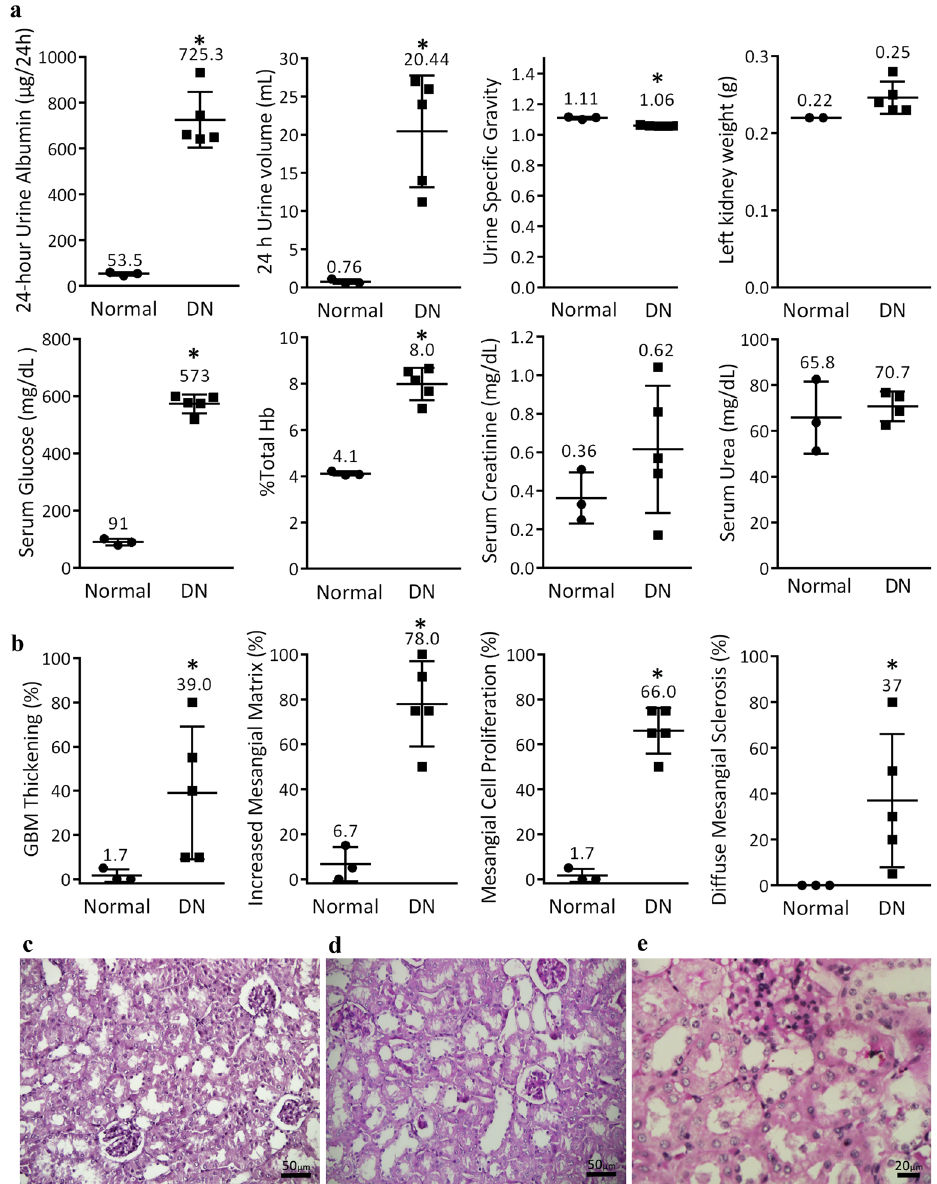
Figure 2. The mouse model of DN was validated with different parameters. A mouse model of DN was established using streptozotocin and validated after 3 months using functional ( a ) and histopathological ( b ) assessments. Representative fields of normal ( c ) and DN ( d , e ) kidneys are shown. Data are reported as means ± SD. Asterisks represent P- value ≤ 0.05. GBM: glomerular basement